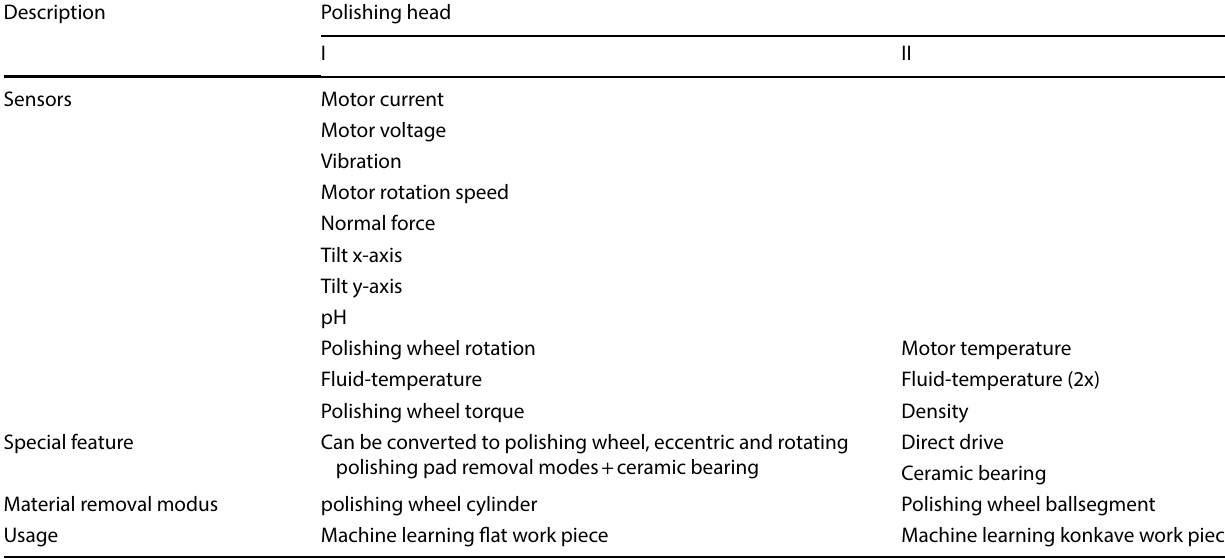
Table 1 Overview of the polishing heads built up and used